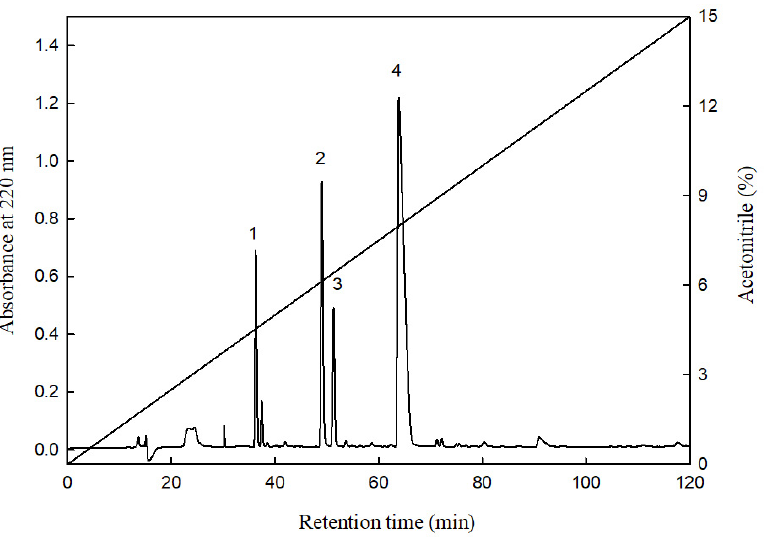
Figure 2. An elution profile of the fraction D from Figure 1 by reversed-phase HPLC. C 18 Column: Synergi 4 μ m Hydro-RP 80A (10 × 250 mm; particle size, 4 μ m; Phenomenex, Torrance, CA, USA); elution A (deionized water containing 0.1% trifluoroacetic acid (TFA) and B (100% acetonitrile containing 0.1% TFA); mobile phase: linear gradient from 0 to 15% of B within 120 min; and flow rate of 1.0 mL/min at room temperature, and detection at 220 nm.